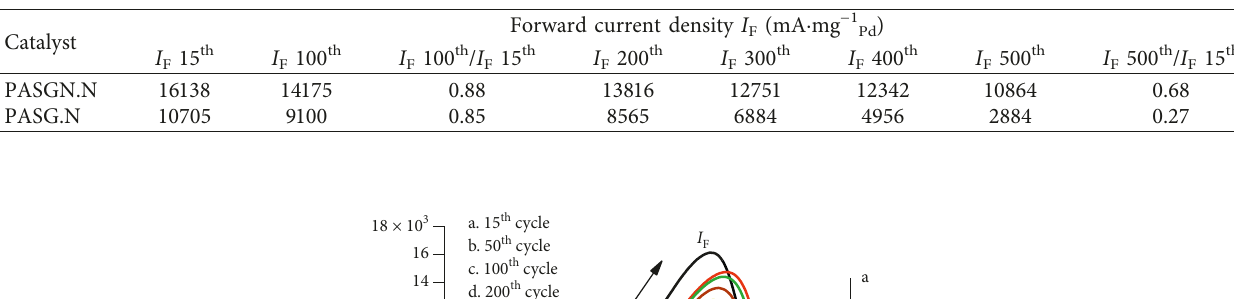
2 H 5 OH 1 M) solution